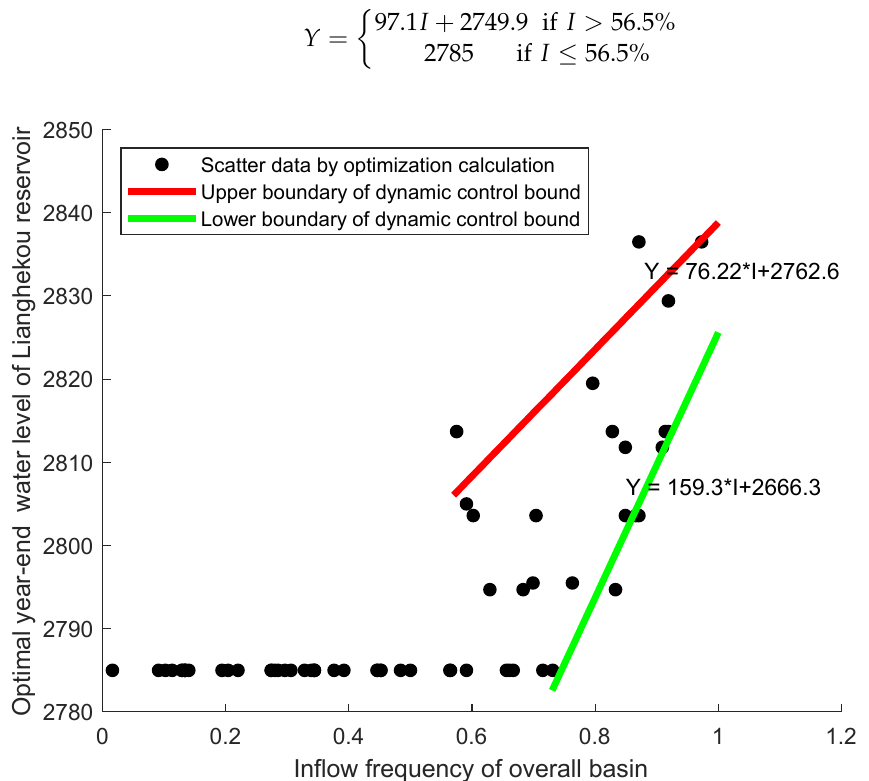
Figure 9. Dynamic control bound of yearly drawdown level constructed by the overall inflow series of the whole basin.